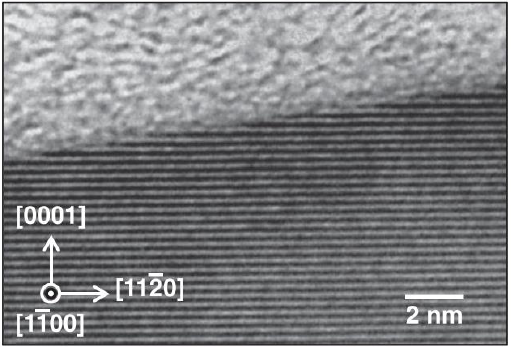
Figure 29. High-resolution TEM image of a CARE-processed 4H-SiC surface [58].